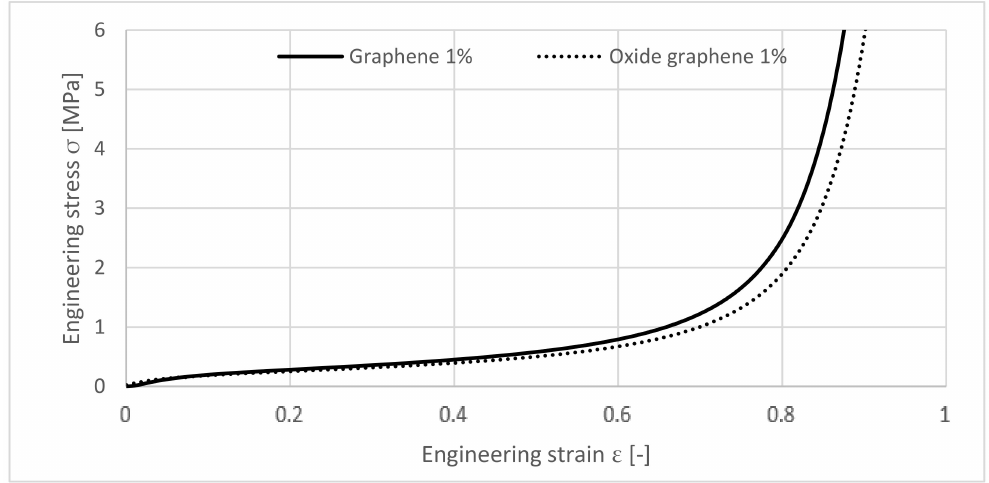
Figure 7. Comparison between samples with 1 wt.% GNP and 1 wt.%